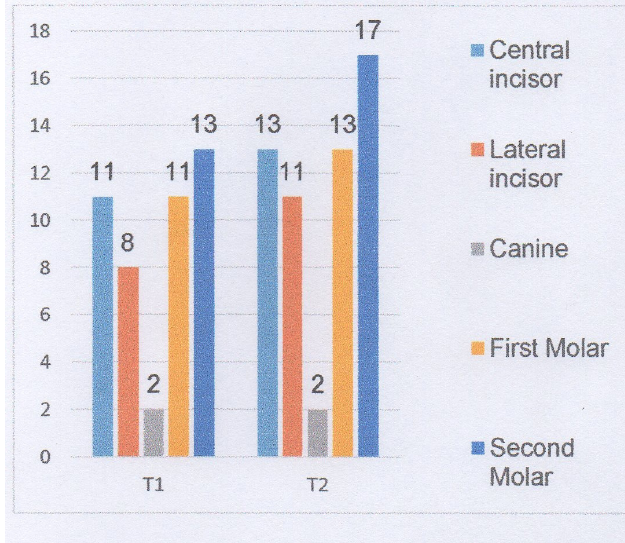
Fig. 1 - Upper deciduous teeth with carious lesions. Parnaíba-PI. 2016.